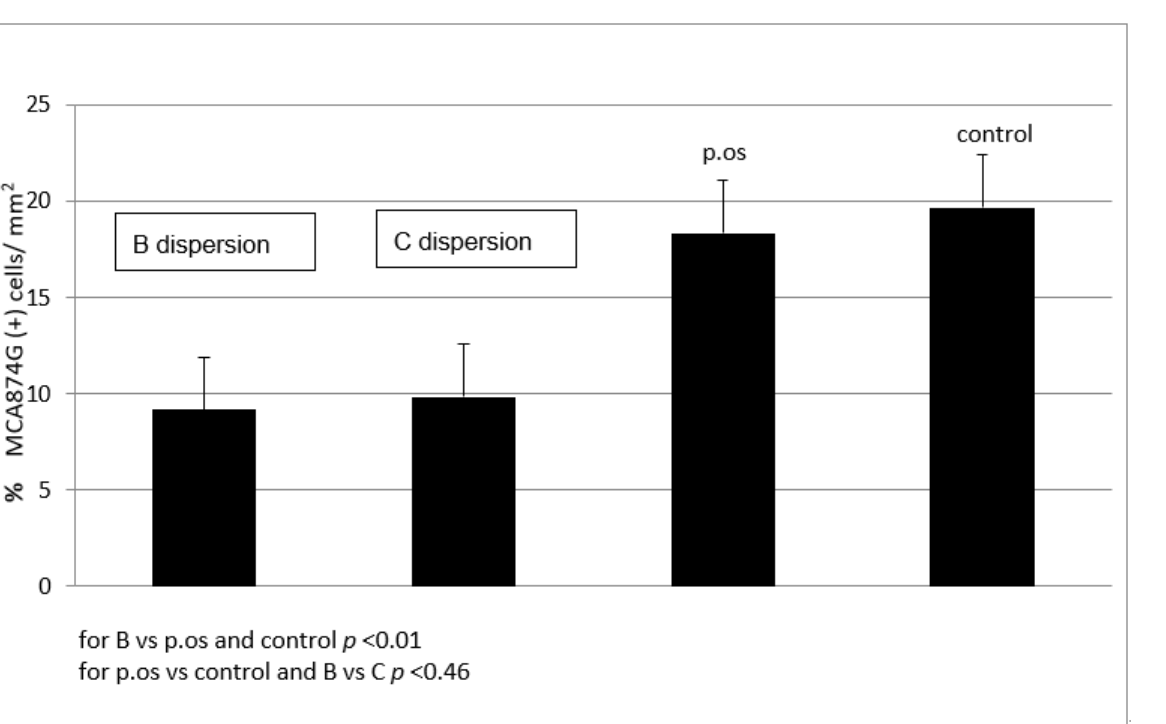
Figure 7. The presence of macrophages in the wall of the aorta after 24 h (groups receiving SVPLA (B and C SVPLA) vs. SV p.os and control). SV dispersion concentration; B: 0.1750 mg/mL, C: 0.0875 mg/mL. SV orally 0.6 mg/kg; Control; saline 0.9% NaCl. Each group n = 6; six vascular samples (aorta) were tested per animal (total 36 per group).